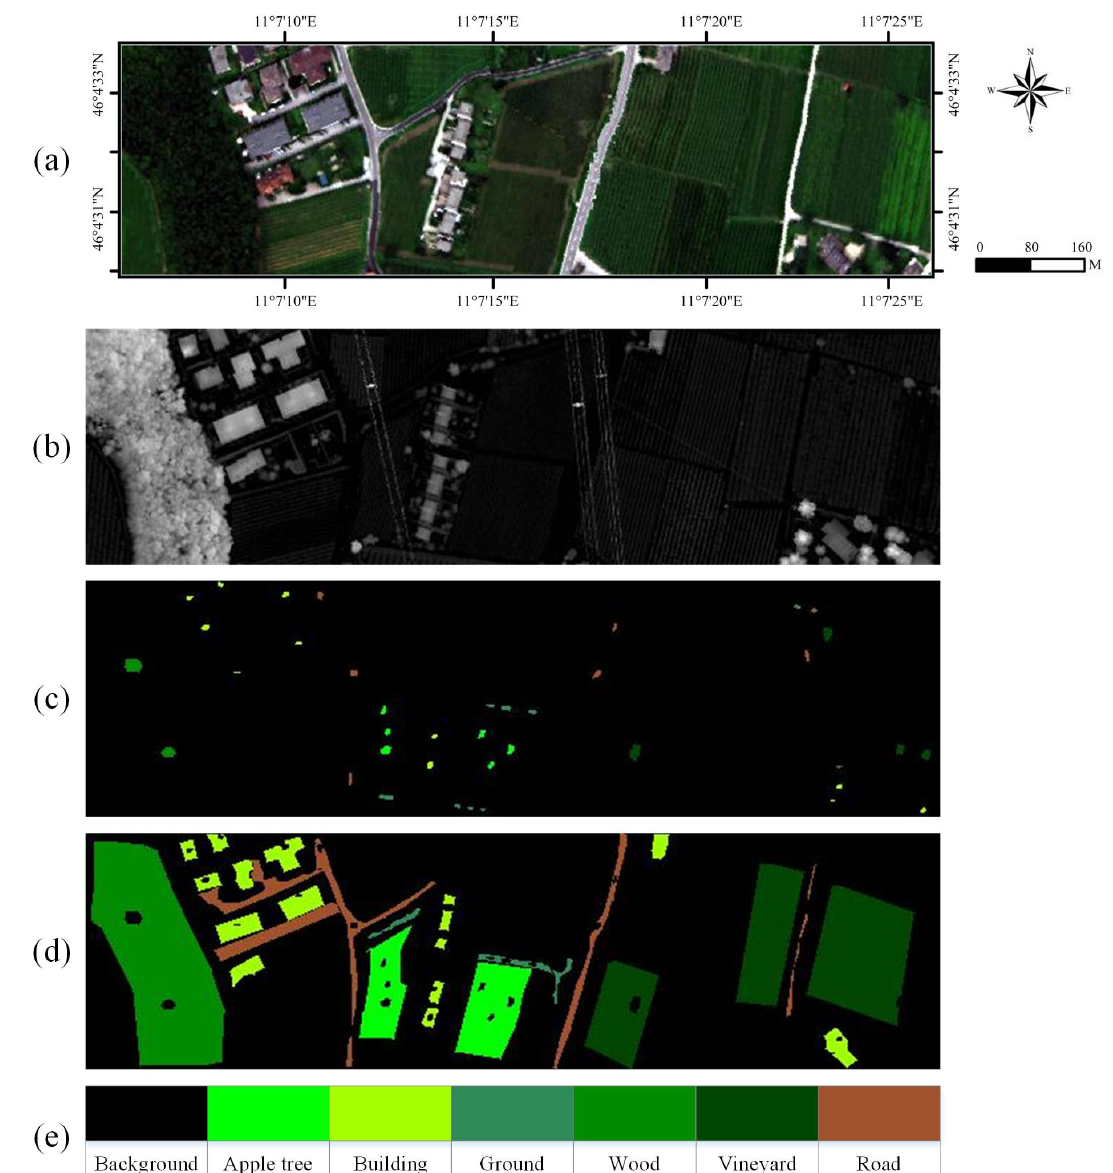
Figure 2. Trento dataset. ( a ) False color image of hyperspectral image (HSI) (No. 28, 18, and 8). ( b ) Light Detection and Ranging (LiDAR). ( c ) Training image. ( d ) Testing image. ( e ) Class